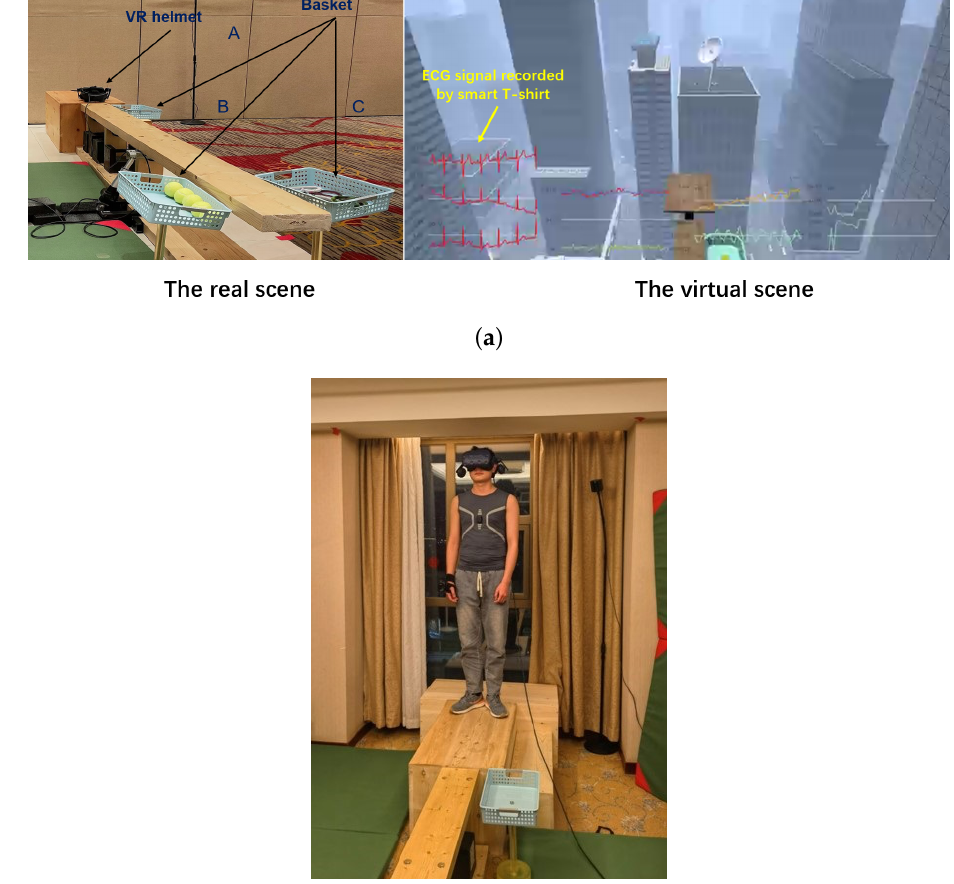
Figure 3. VR experiment. ( a ) Experimental scene and VR scene. ( b ) A subject performing the VR